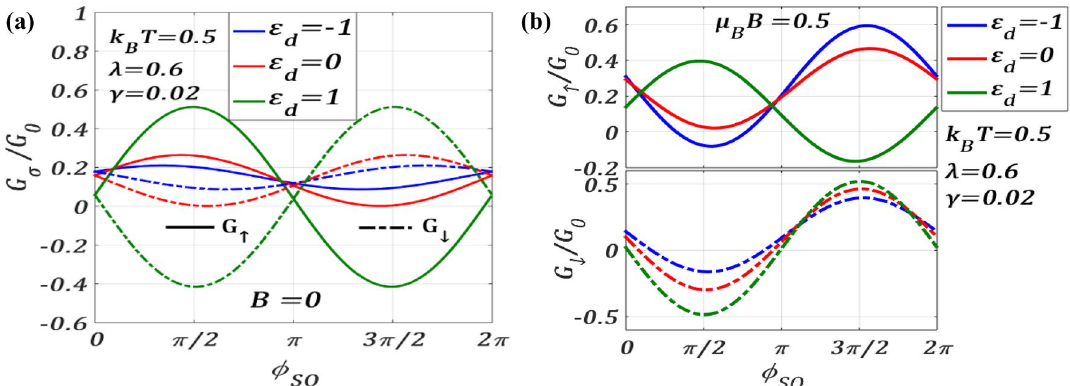
Figure 10. ( a ) Spin-resolved differential conductance G σ / G 0 versus φ SO for different values of dot energy ε d at (cid:31) 0.6, t SD 0.2, γ 0.02, eV b 0.5 ( a ) for B = = = =